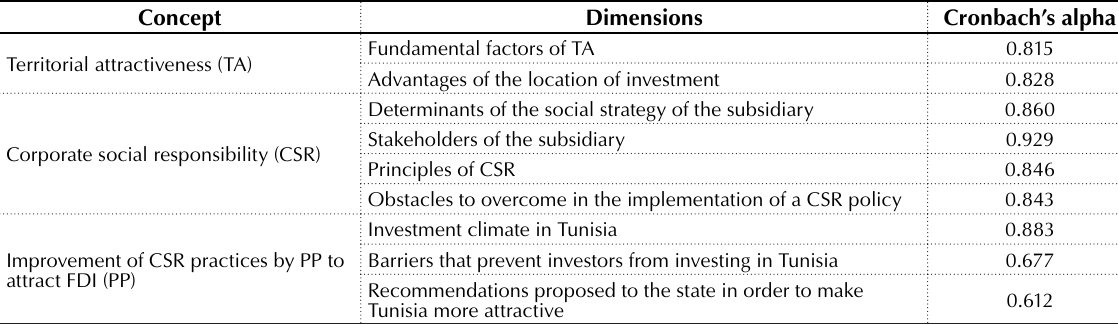
Table 3. Cronbach’s alpha